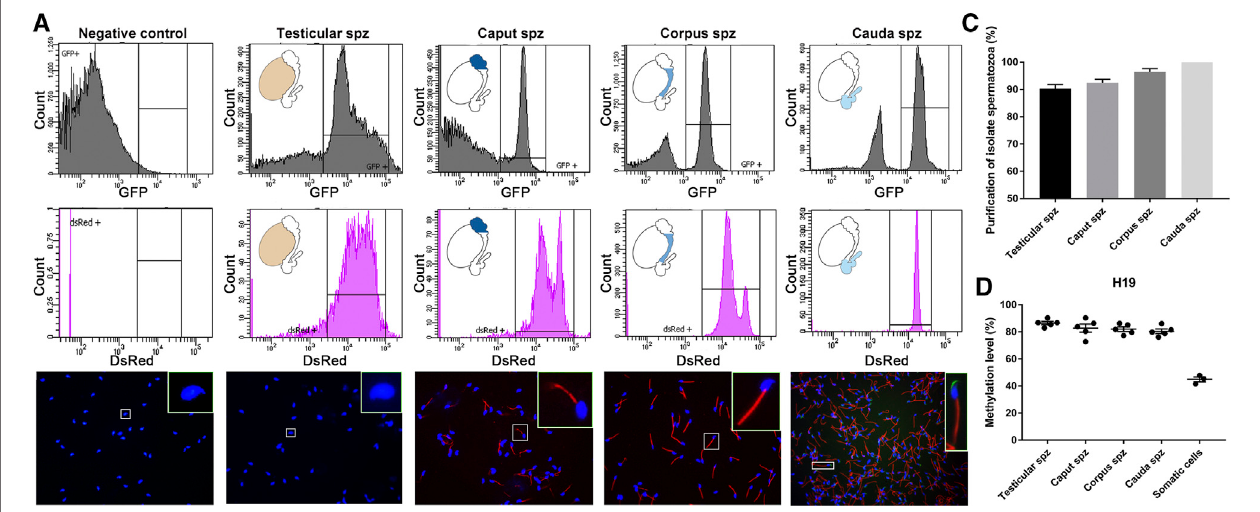
FIGURE 2 | Isolation of testicular, caput , corpus and cauda spermatozoa by fl uorescence-activated cell sorting (FACS). (A) Spermatozoa were isolated by FACS based on their endogenous EGFP and dsRed fl uorescence. Spermatozoa from wild-type mice and spermatozoa collected by intraluminal perfusion from the cauda epididymidis were used as a negative control and positive control, respectively. Puri fi cation levels of spermatozoa were assessed by cell counting under a fl uorescence microscope (B,C) and by H19-IGF2 methylation pyrosequencing (D) . Somatic cells isolated from the tail of transgenic mice were used as a reference. Spz: spermatozoa